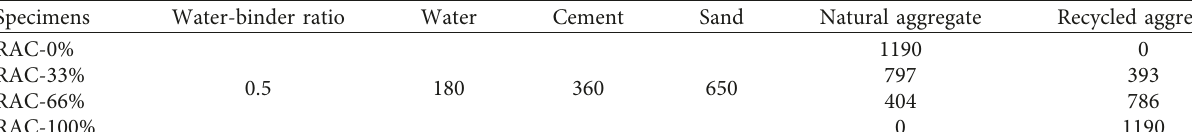
Table 2: Mix proportion of RAC (kg/m 3 ).